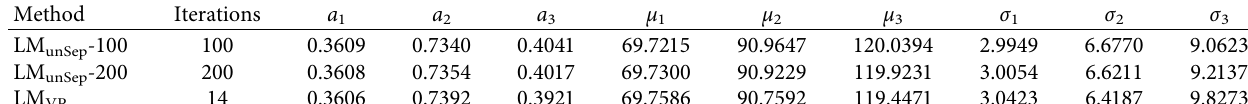
Figure 3: Iterative process for calculating a , μ s s , and σ s from the five groups of data using the two different methods. Table 4: Parameters calculated using the two models in a real experiment.